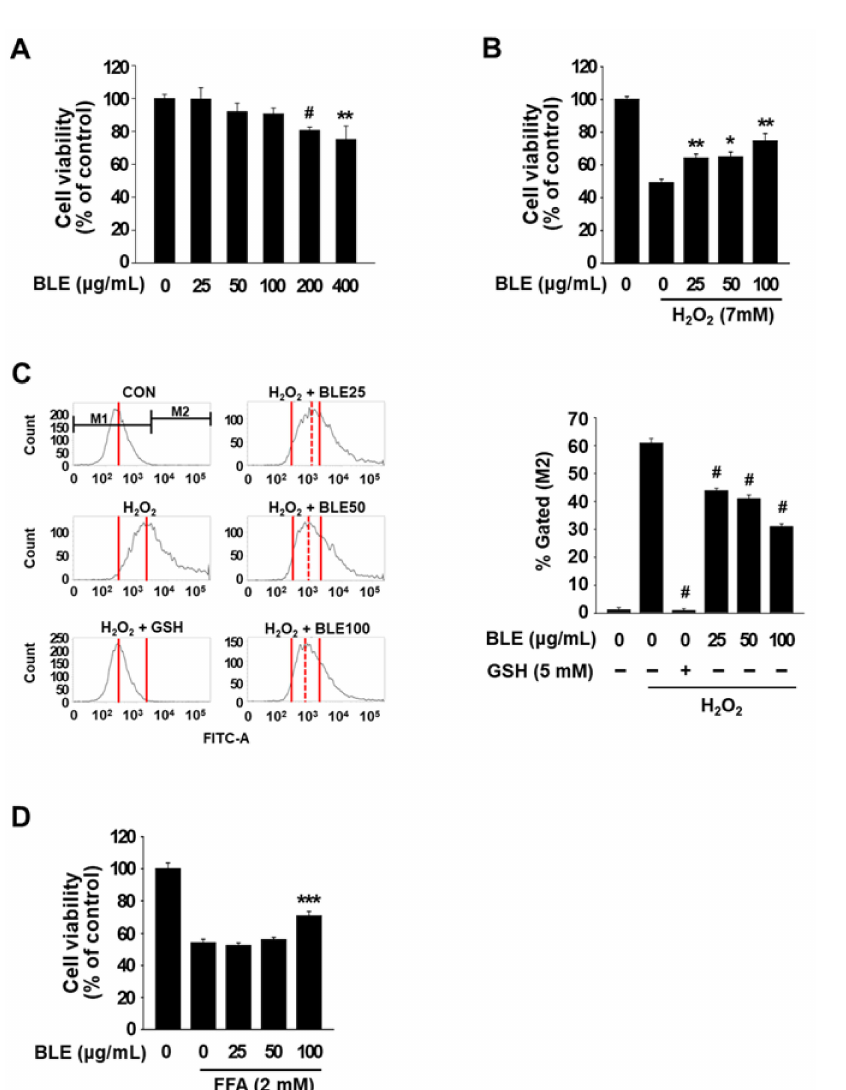
Figure 2. Protective effects of BLE against oxidative stress-induced cytotoxicity in AML12 cells. Cells were treated with the indicated concentrations of BLE for 24 h ( A ). After 24 h treatment with BLE, the media were replaced with new media containing H 2 O 2 ( B , C ) and free fatty acids ( D ), and the cells were incubated for another 4 h. Cell viability was determined by an MTT assay ( B , D ) and intracellular ROS level was measured by flow cytometry ( C ). All results are expressed as means ± SEM ( n ≥ 3). * p < 0.05, ** p < 0.01, *** p < 0.005, and # p < 0.001 vs. the H 2 O 2 or free fatty acids (FAA)